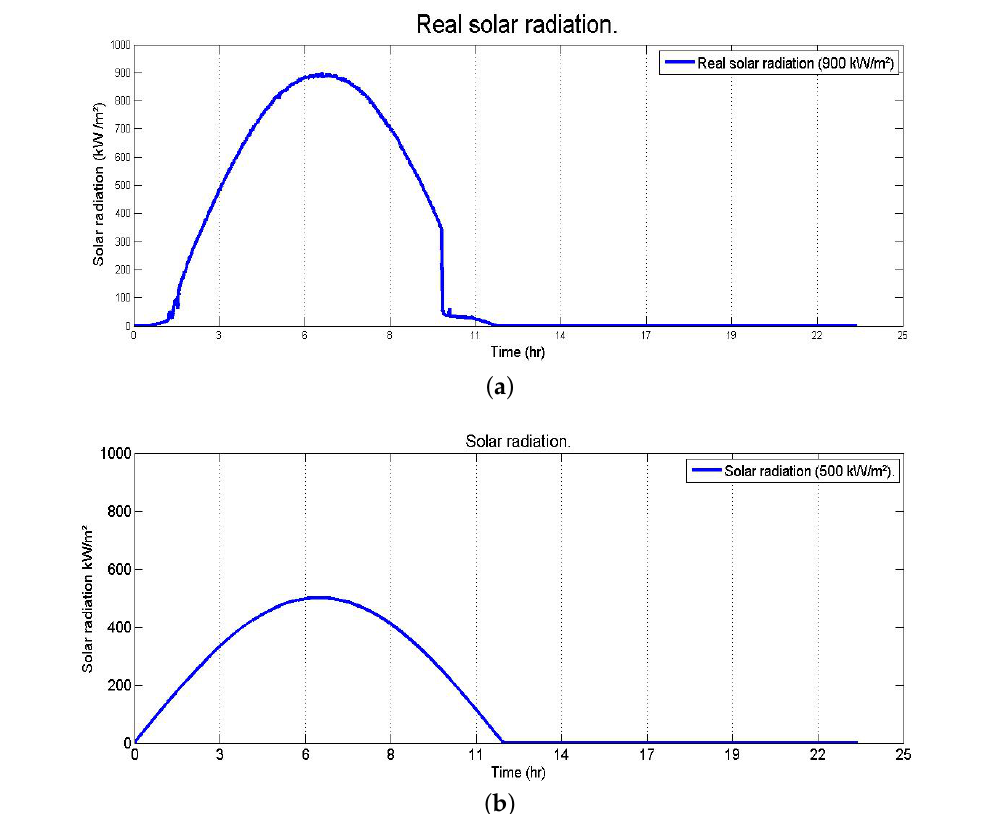
Figure 13. ( a ) Real solar radiation of a normal day of the state of Colima in seconds; ( b ) solar radiation of 500 kW/ m 2 , which is considered as low radiation. ( a ) Real solar radiation; ( b ) solar radiation of 500 kW/m 2